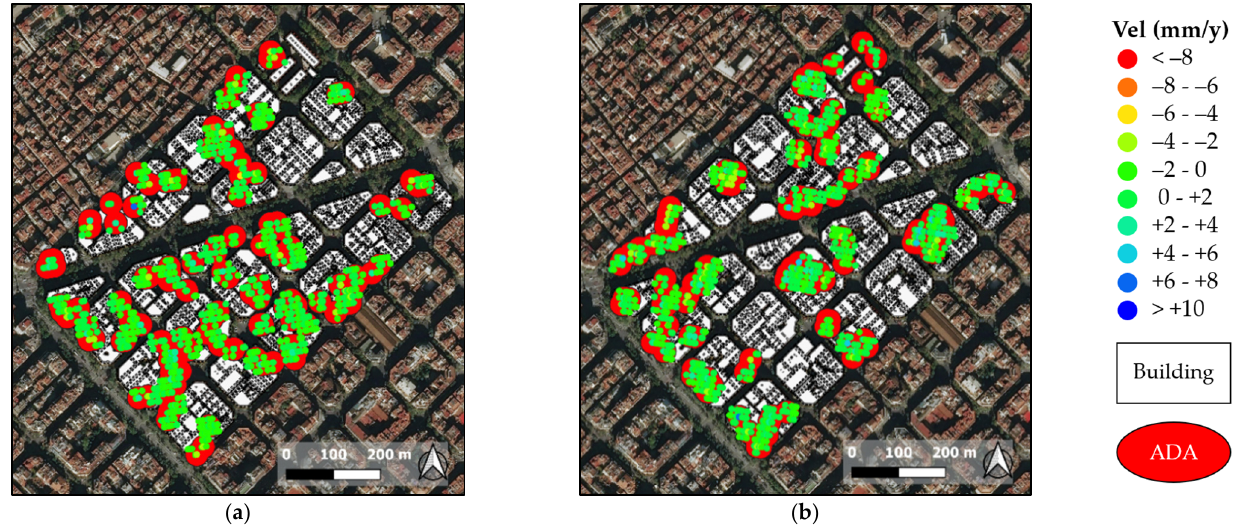
Figure 4. ADA extraction from the active PSs of the selected area of Eixample from ( a ) ascending and ( b ) descending datasets.